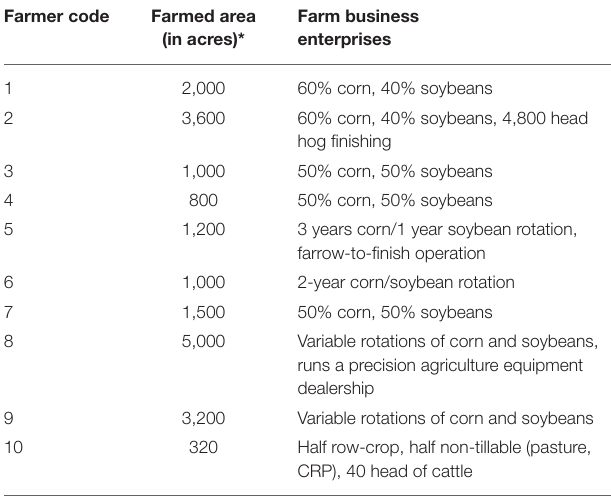
TABLE 1 | Profile of interviewed